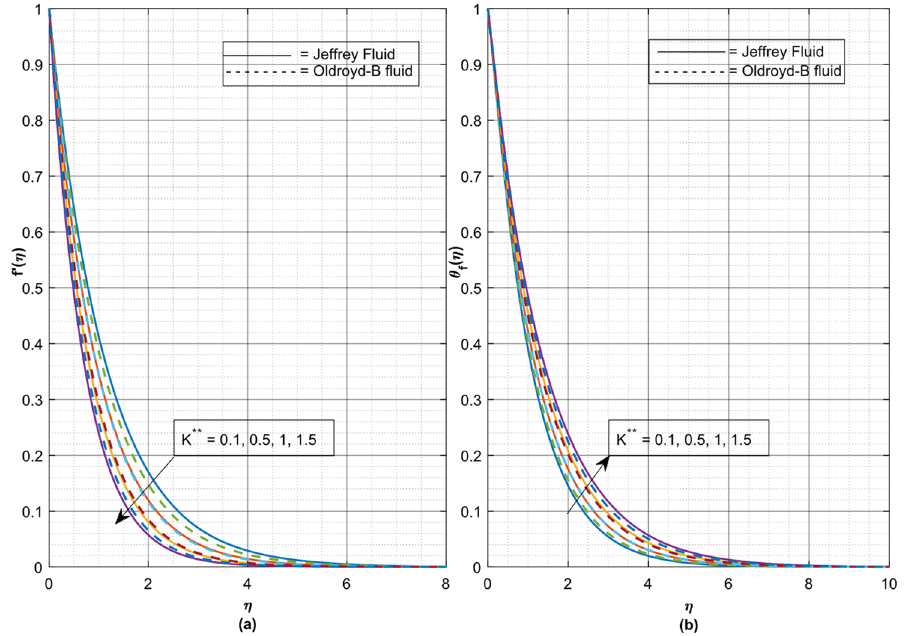
( ) ( ) θ η Figure 2. ( a ) Impact of K ∗∗ on f (cid:48) ( η ) and ( b ) Impact of K ∗∗ on θ f ( η ) . ' f η and (b) Impact of ** K on Figure 2. (a) Impact of ** K on . f Figure 3a is plotted to explore the domination of M on f (cid:48) ( η ) for both Oldroyd-B and ( ) ' f η for both Oldroyd- Jefferey liquids. The improvement in M weakens the f (cid:48) ( η ) of both liquids. The magnetic Figure 3a is plotted to explore the domination of M on field’s influence on the flow field is indicated by the M . The presence of a magnetization in ( ) ' f η of both liquids. the fluid flow region causes the fluid to move more slowly. In general, an increase in the M produces the opposite force to the flow, which is known as the Lorentz force. This force tends to diminish the thickness of the velocity boundary layer. Further, for lower values of M , f (cid:48) ( η ) for Oldroyd-B liquid is strongly triggered and declines faster than Jefferey liquid. However, for higher values of M , the f (cid:48) ( η ) of Jeffery liquid is strongly